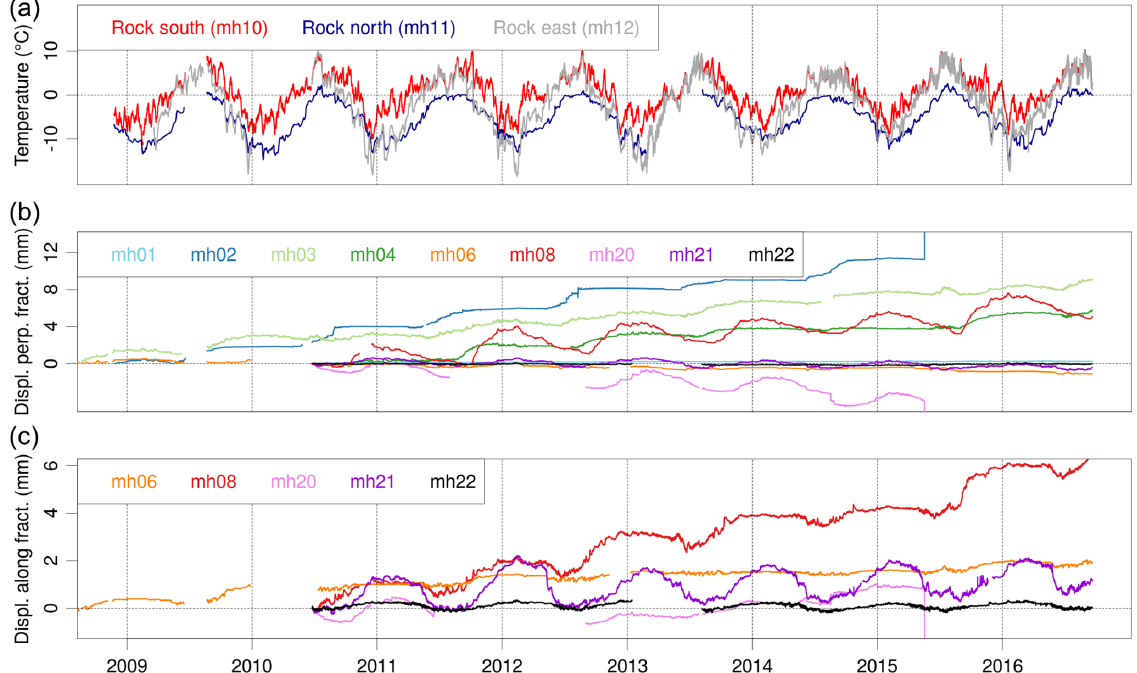
Figure 6. Thermal conditions and fracture displacements at the Matterhorn Hörnligrat field site over a course of 8 years. (a) The thermal conditions are shown by characteristic rock temperatures for the south, east and north side of the ridge measured at a depth of 0 . 85m. The fracture kinematics are shown as normalized displacements (b) perpendicular to and (c) along fractures. A gap in the rock temperature time series of location mh12 (T east ) is filled for the time period November 2012 until July 2013 and from August 2014 onwards, applying quantile mapping using the best regressors approach (Staub et al., 2016) with a coefficient of determination R 2 = 0 .